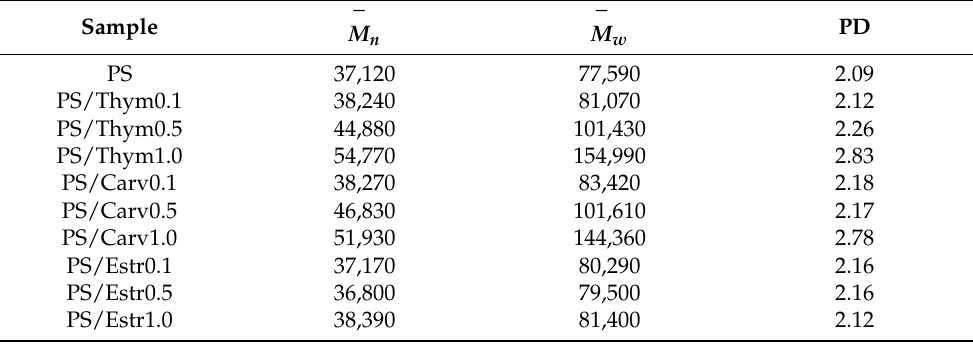
Table 3. Number- and weight-average molecular weights ( M n , M w ), as well as polydispersity of the MWD (PD) of the composite materials based on PS and thymol, carvacrol and estragol at different relative-to-monomer amounts of 0.1, 0.5 and 1.0 wt